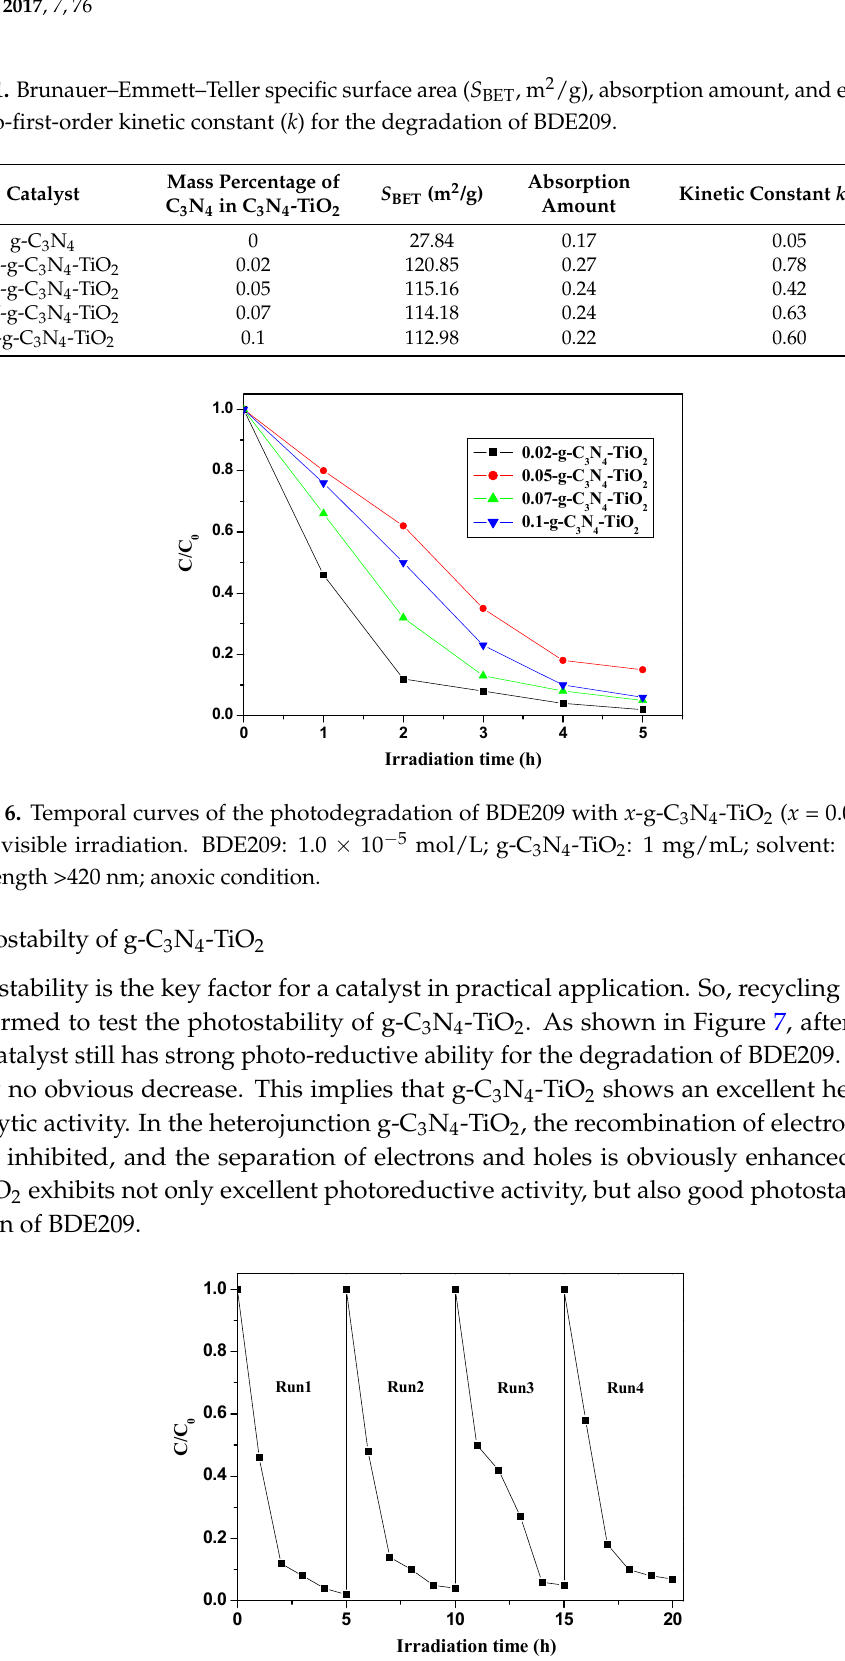
Figure 7. Cycling runs in the degradation of BDE209 with 0.02 ‐ g ‐ C 3 N 4 ‐ TiO 2 under visible irradiation. BDE209: 1.0 × 10 − 5 mol/L; 0.02 ‐ g ‐ C 3 N 4 ‐ TiO 2 : 1 mg/mL; solvent: CH 3 OH; wavelength >420 nm; anoxic condition.